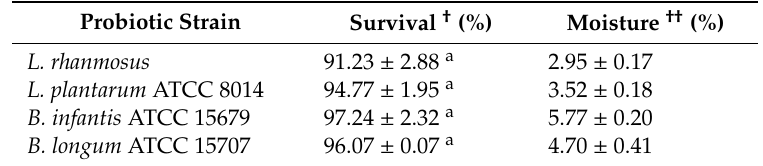
Table 5. Survival of probiotic strains encapsulated by spray drying with chia seed mucilage (0.6% w / v) at 90 ◦ C and moisture content after spray